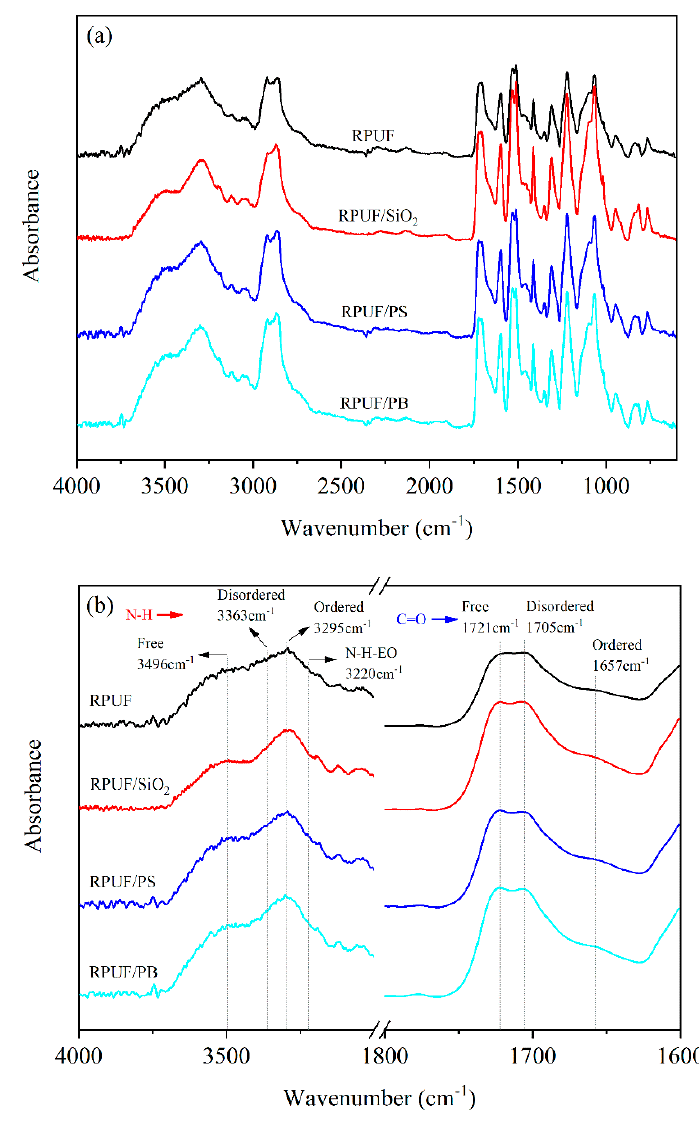
Figure 3. The ATR-FTIR spectra of RPUFs with and without fillers: integrated curves ( a ) and partially enlarged curves ( b ).